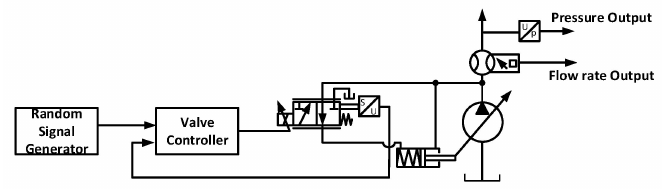
Figure 3. Structure scheme of open-loop identification experiment.